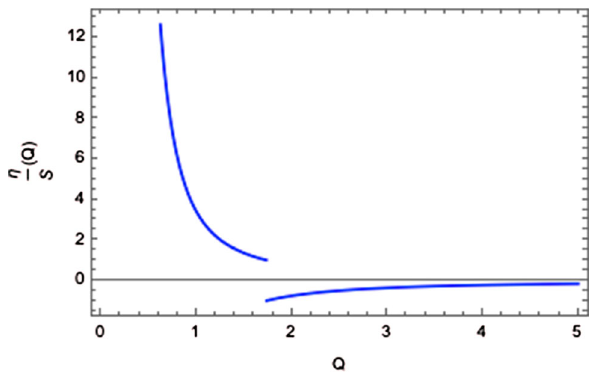
Fig. 2 Plot of Eq. (57) without the factor 1 change of sign in the η/ s ratio for Q =